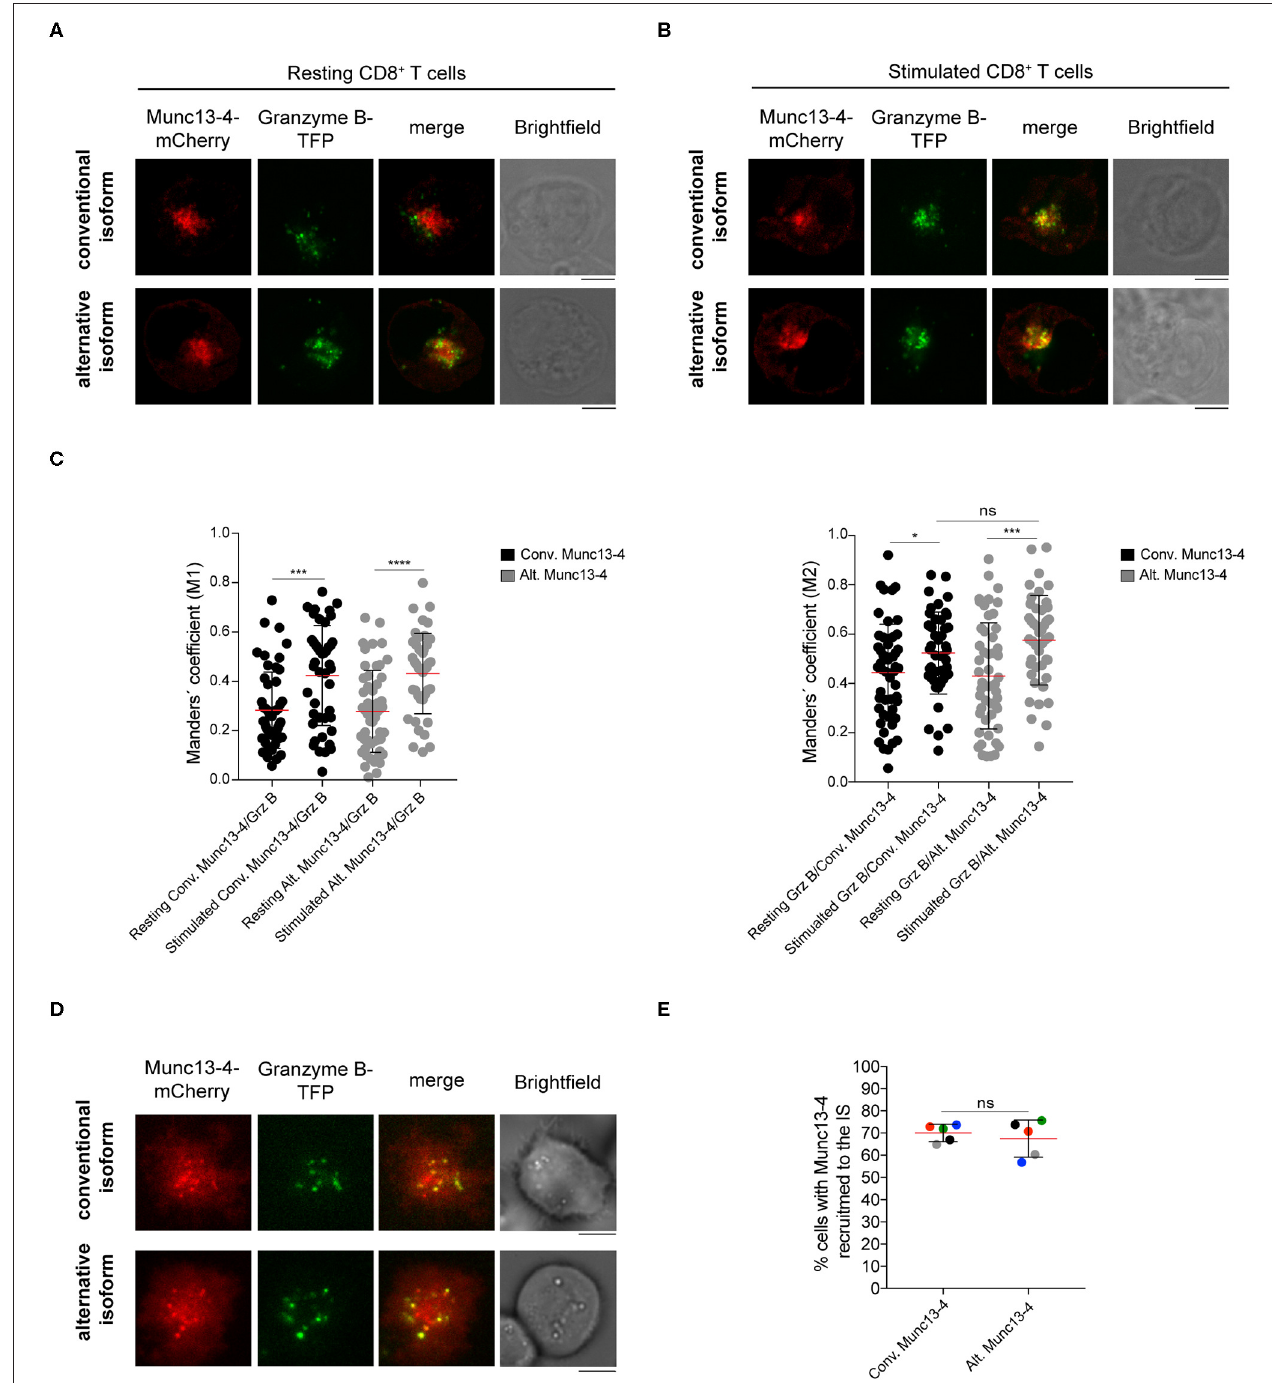
FIGURE 4 | Recruitment of both Munc13-4 isoforms to cytotoxic granules and to the immune synapse. (A,B) Confocal microscopy images of cytotoxic CD8 + T cells from healthy donors transfected with plasmids encoding Granzyme B and conventional or alternative Munc13-4-mCherry. Images show representative cells (A) resting or (B) stimulated with PMA plus ionomycin for 20min at 37 ◦ C prior fixation. Upper panels show cells transfected with conventional Munc13-4-mCherry, whereas lower panels show cells transfected with alternative Munc13-4-mCherry. (C) Colocalization of Munc13-4 isoforms and Granzyme B in both resting and stimulated conditions was calculated as Manders’ overlap coefficient. Plots represent cumulative data from three healthy donors ( n = 51 cells for conventional Munc13-4, n = 52 cells for alternative Munc13-4 from resting CD8 + T cells; n = 44 cells for both Munc13-4 isoform from stimulated CD8 + T cells). Bars depict mean ± SD, whereas dots represent single cells. P -values were calculated using a two-sided Mann-Whitney test. ns, non-significant * P ≤ 0.05, *** P ≤ 0.001; *** P ≤ 0.0001.